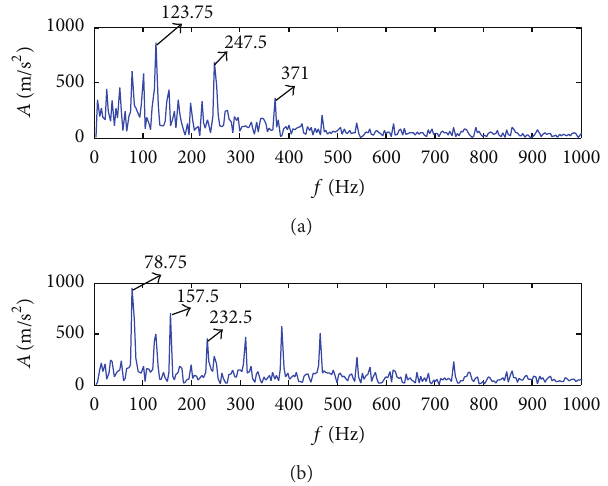
Figure 6: Demodulation spectra after BSS and NSP